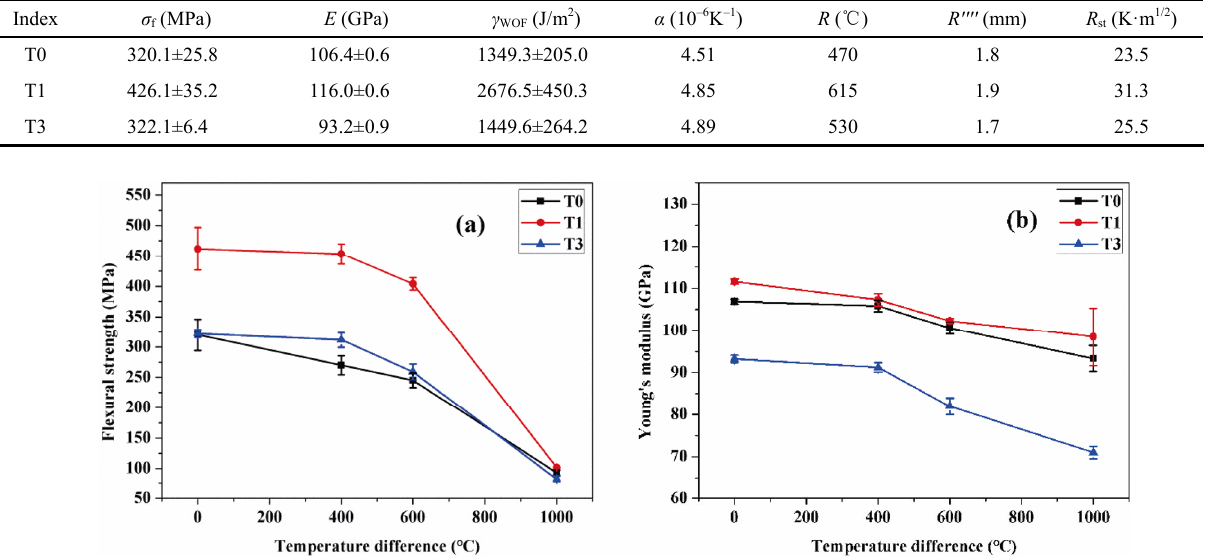
Fig. 4 Flexural strength and Young’s modulus as a function of quenching temperature